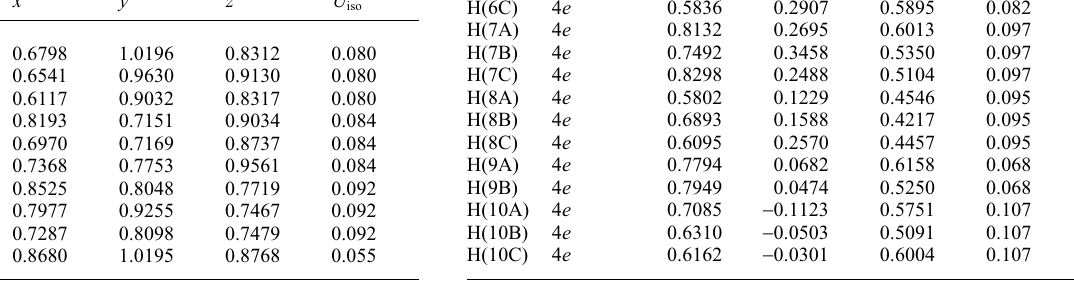
Table 3. Atomic coordinates and displacement parameters (in Å 2 )